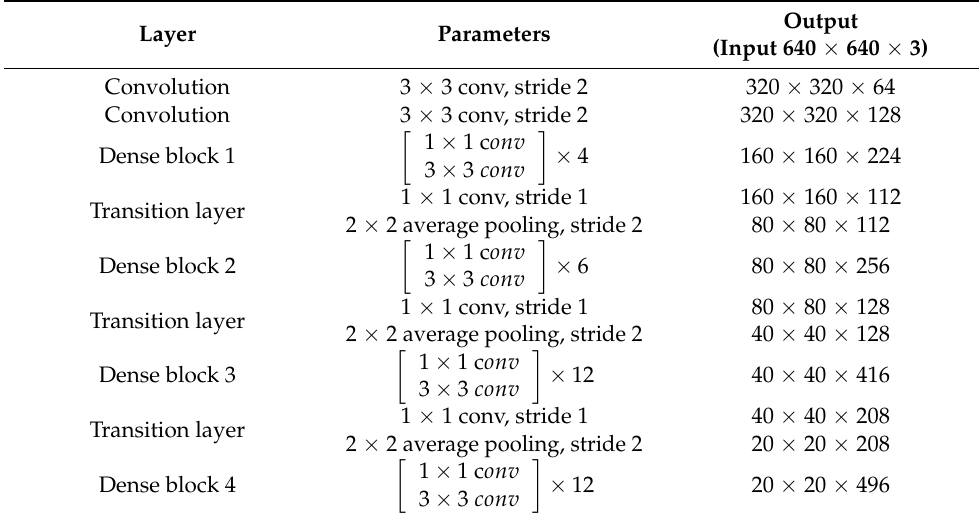
Table 1. Swish-DenseNet architecture (growth rate k = 24 in each dense block). Layer Parameters